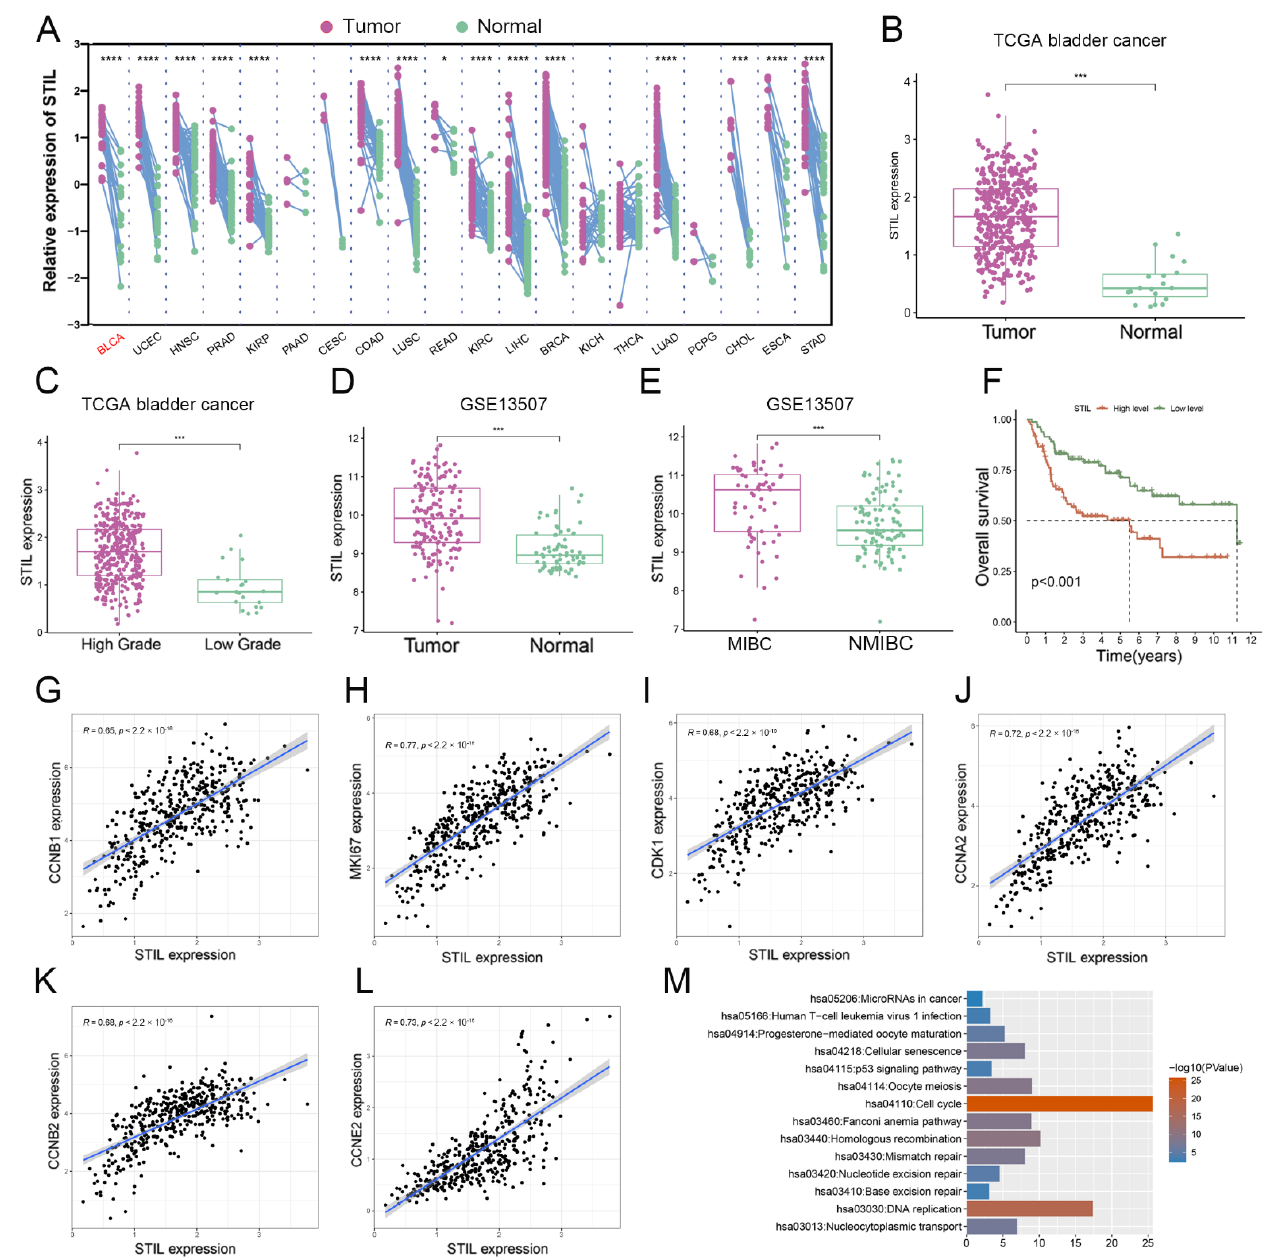
Figure 1. STIL was highly expressed in BC and was inextricably intertwined with the cell cycle. ( A ) Paired samples grouped by cancer from the TCGA show STIL expression in human cancers. Each point represents one sample. p -values are based on a two-tailed Student ’s t-test. ( B ) Gene expression of STIL in BC and normal tissues based on TCGA database. ( C ) Gene expression of STIL in high-grade and low-grade BC tissues based on TCGA database. ( D ) Gene expression of STIL in BC and normal tissues based on the microarray data GSE13507. ( E ) Gene expression of STIL in MIBC and NMIBC based on the microarray data GSE13507. ( F ) The Kaplan – Meier plot shows the overall survival for STIL expression based on the GSE13507. ( G – L ) A correlation of STIL expression with proliferation marker MKI67 and the genes regulating the cell cycle, including CCNB1, CDK1, CCNA2, CCNB2, and CCNE2. ( M ) KEGG pathway enrichment results for the genes significantly correlated with STIL. STIL, SCL/TAL1 interrupting locus; BC, bladder cancer; MIBC, muscle-invasive bladder cancer; NMIBC, non-muscle invasive bladder cancer ( * p < 0.05, *** p < 0.001 and **** p < 0.0001).